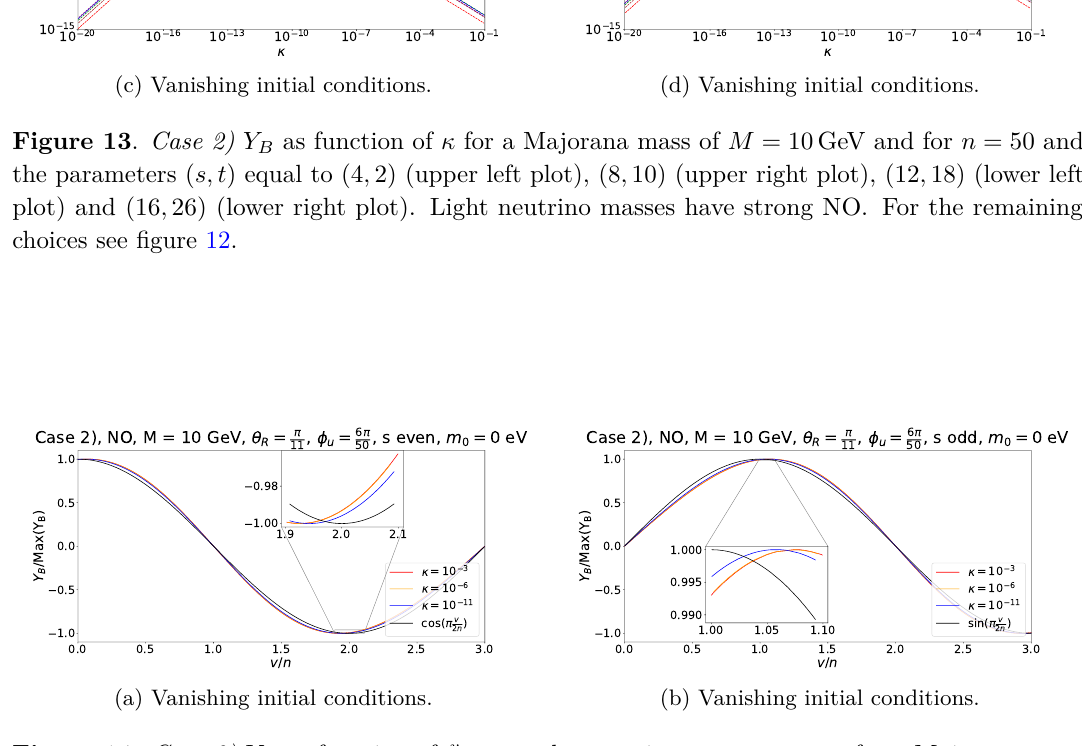
Figure 14 . Case 2) Y B as function of v M = 10 GeV and different values of κ , κ ∈ { 10 − 3 , 10 − 6 , 10 − 11 } . The group theory parameters n and u are chosen as n = 50 and u = 6 so that φ u = 6 π being even (left plot) or odd (right plot). Light neutrino masses have strong NO. We compare the numerical results (coloured curves) with the analytical expectation cos (cid:0) πv (for s odd) arising from the CP-violating combinations, see eq. (6.25), shown in